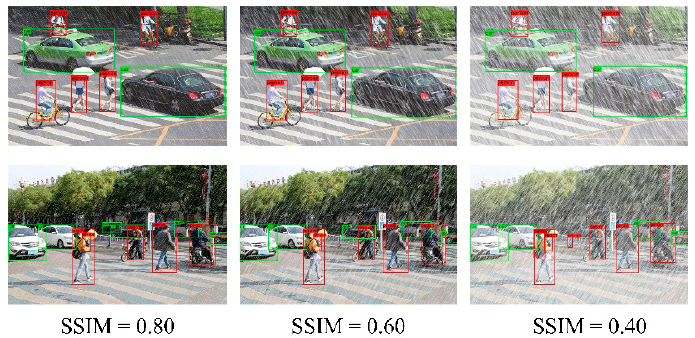
Figure 9. The comparison of the detection results under different SSIM values.